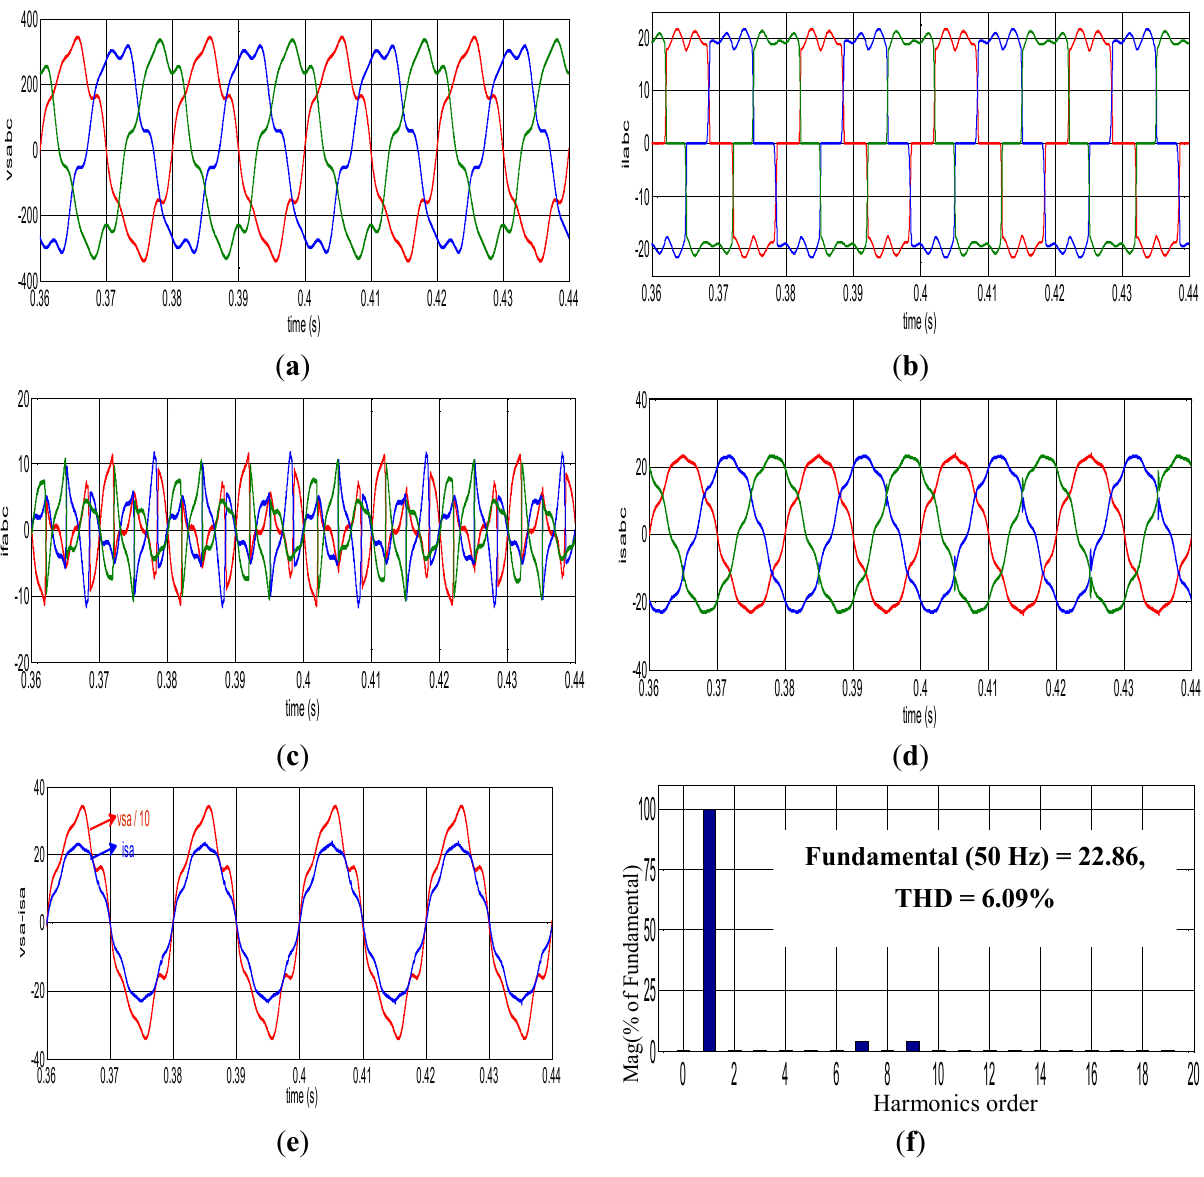
Figure 10. Simulation results of balanced distorted grid voltage: ( a ) three-phase line voltages; ( b ) three-phase load currents; ( c ) three-phase filter currents; ( d ) three-phase line currents; ( e ) line voltage and current, phase-a; ( f ) frequency spectrum of line current,